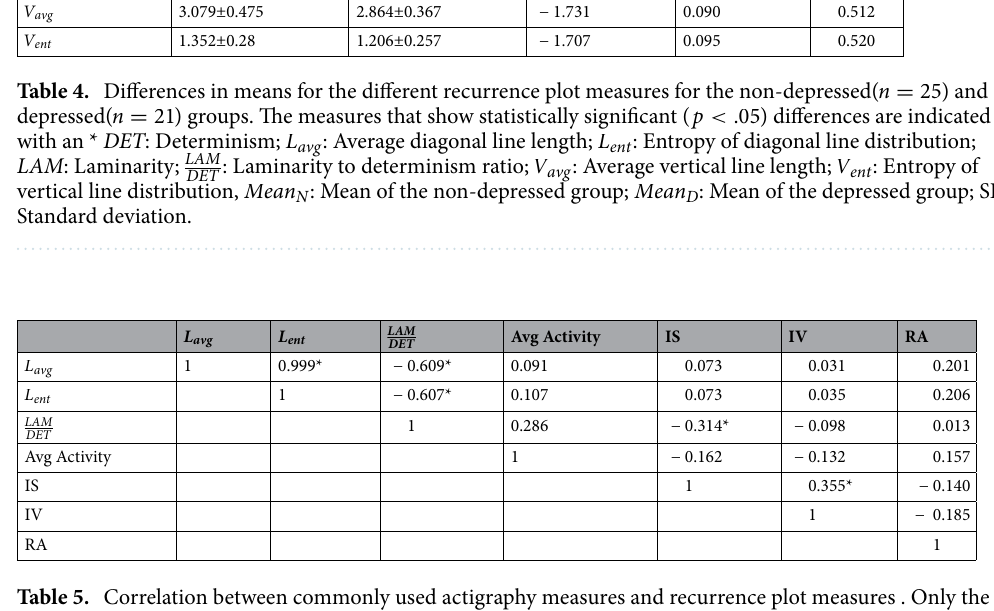
Table 5. Correlation between commonly used actigraphy measures and recurrence plot measures . Only the recurrence plot measures that showed significant differences between the two groups are listed. The table lists the Spearman correlation coefficient. Significant correlations( p < 0.05) are marked with an *. IS: Interdaily stability; IV: Intradaily variability; RA: Relative Amplitude; L avg : Average diagonal line length; L ent : Diagonal line entropy; LAM DET : Laminarity to determinism ratio.